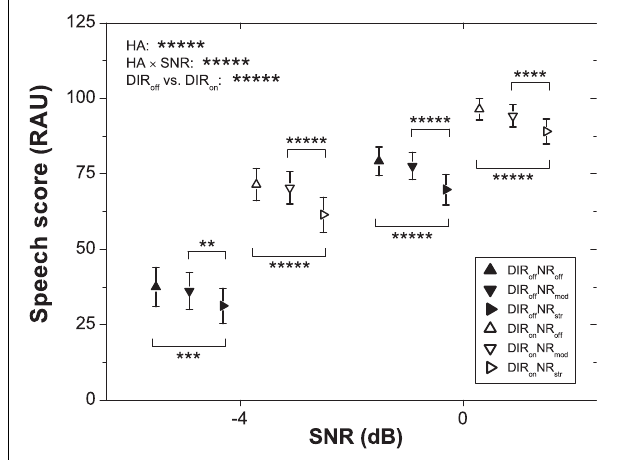
FIGURE 2 | Mean speech scores for the six HA conditions and two SNRs. Error bars show 95% confidence intervals. Horizontal bars